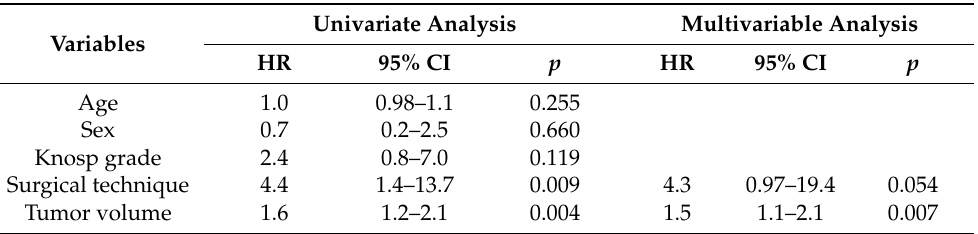
Table 3. Univariate and multivariable analyses of factors which resulted in incomplete resection and tumor remnants in intraoperative MRI.